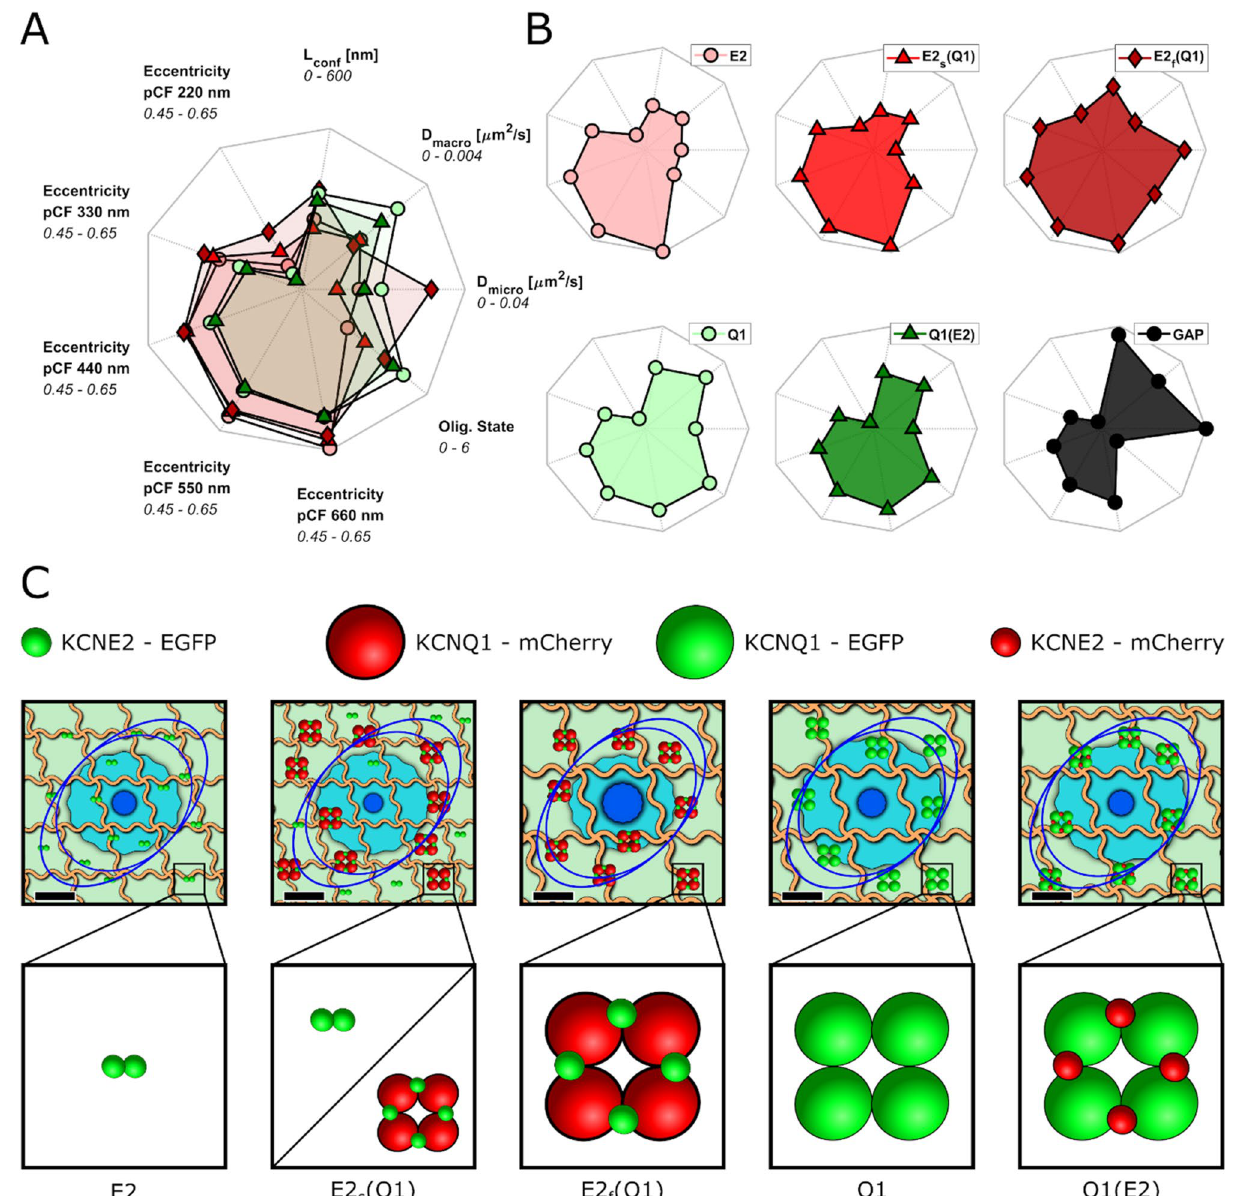
state for the KCNQ1-KCNE2 complex. Scale bar for the model is 200 nm and proteins are shown 10 × their actual size. The dark blue and light blue circles represent the area covered by the diffusion of the protein in 0.5 s (calculated from D micro ) and 60 s (calculated from D macro ), respectively. Orange lines represent the nano-domains and the blue ellipses show the eccentricity as short scale (220 nm, internal ellipse) and long scale (660 nm, external